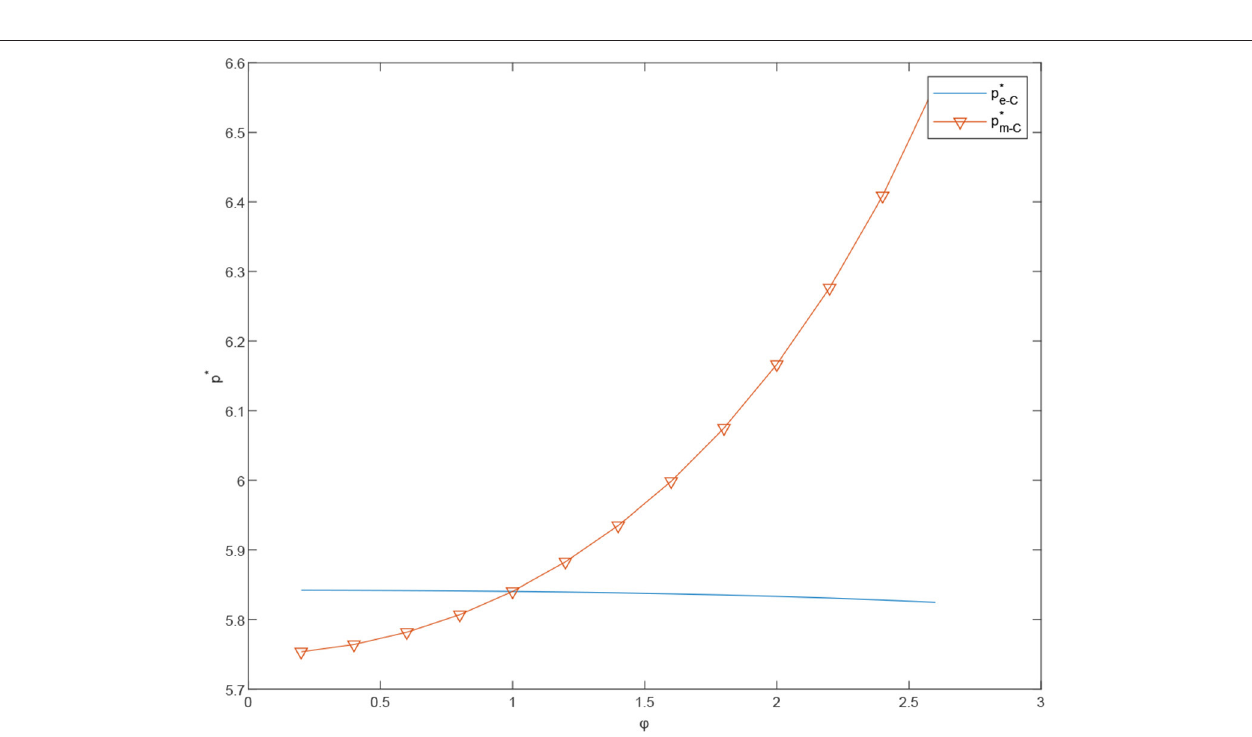
Frontiers in Psychology |